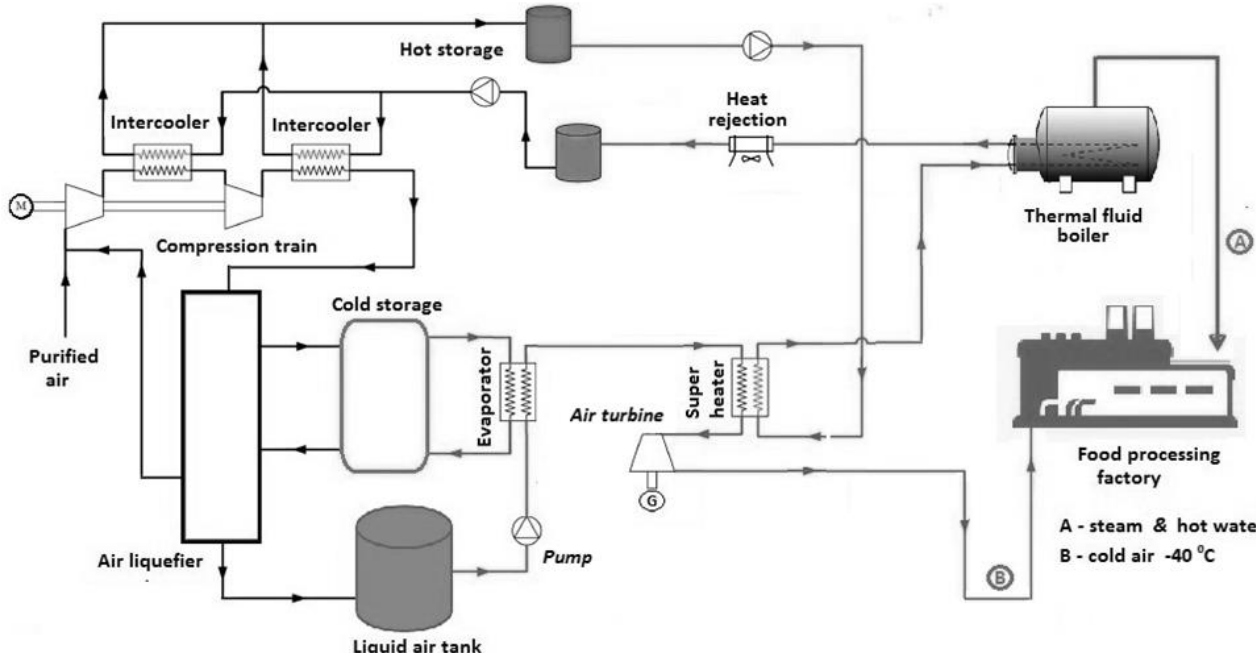
Figure 5. Layout of the LAES plant with tri-generation capability — scenario B.